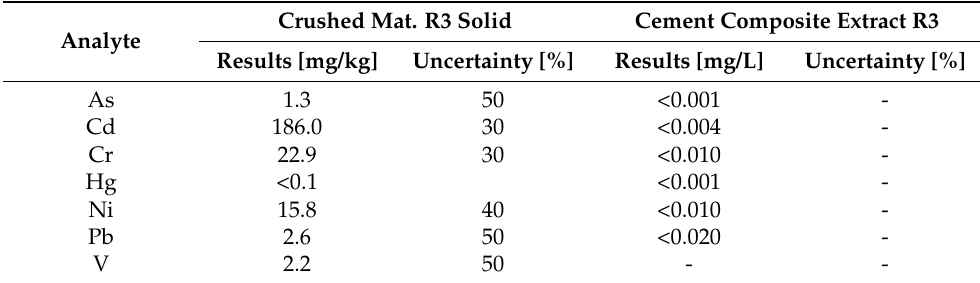
Table 1. Chemical composition of photovoltaic waste glass and cement composite